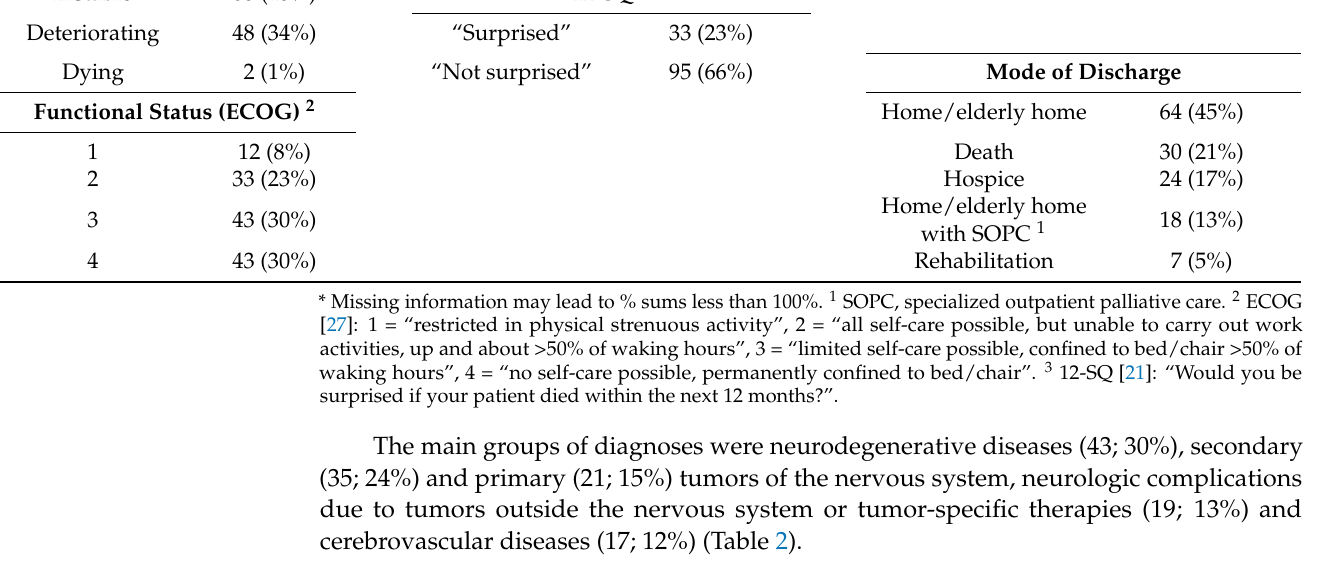
Table 2. Spectrum of